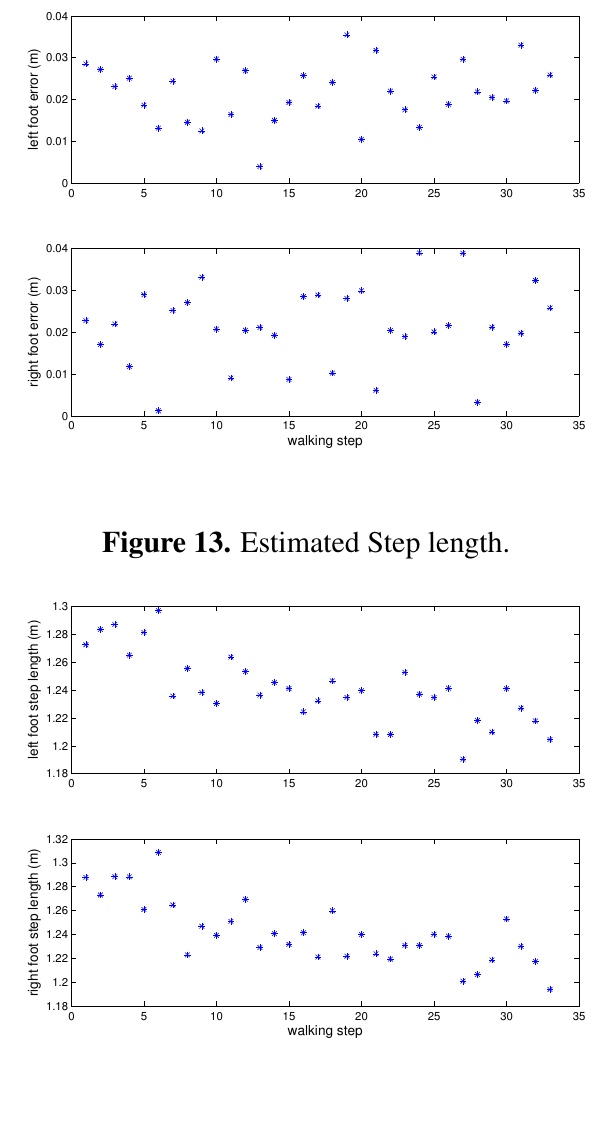
Figure 12. Step length estimation error.